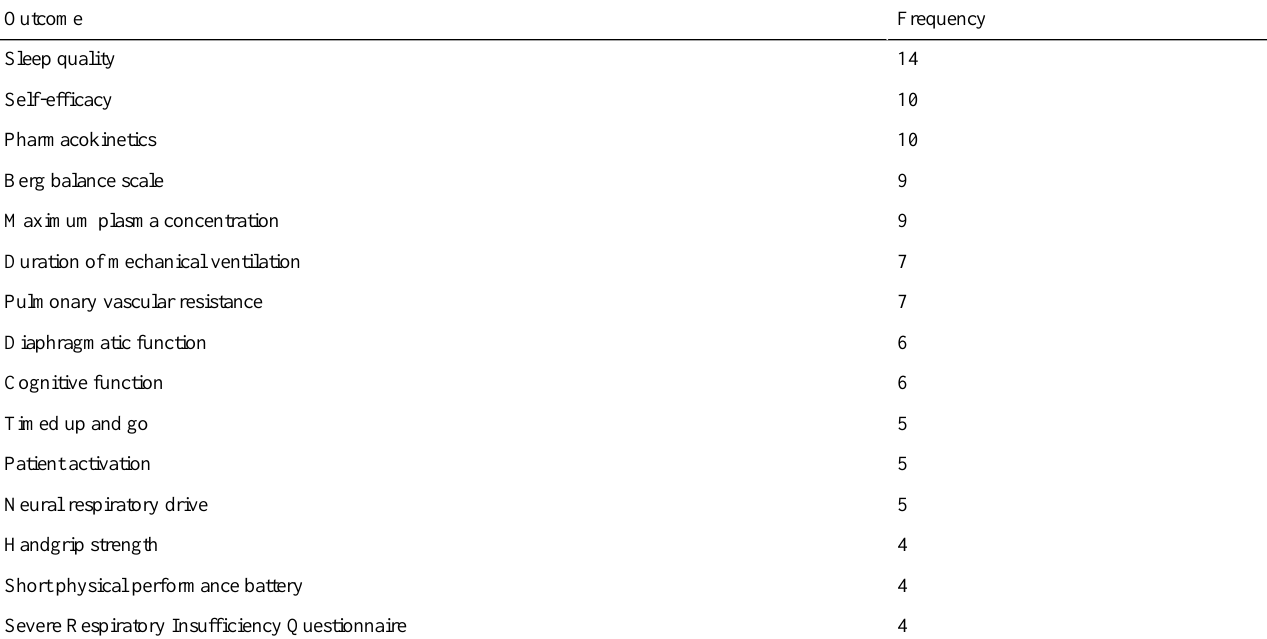
Table 5. Top false positives (outcomes generated by the pipeline but not appearing in any of the abstracted